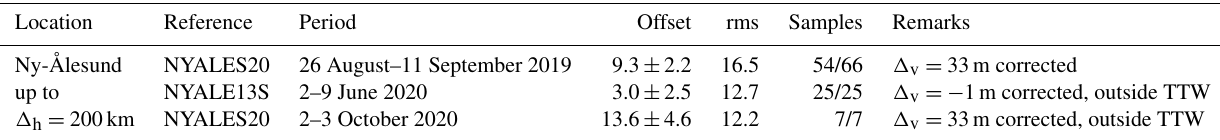
Figure 10. Hourly ZTD values (black) compared to ZTDs derived for IGS station NYA2 (Ny-Ålesund, Svalbard, blue) during Au- gust/September 2019 (a) , June 2020 (b) and October 2020 (c) , and to ZTDs derived from ERA5 (green) and VLBI stations NYALES20 and NYALE13S (orange); the distance between RV Polarstern and NYA2 is represented in red. Table 4. Summary of differences with respect to VLBI (always computed as the difference of RV Polarstern and the reference); number of used/all samples is given; units: